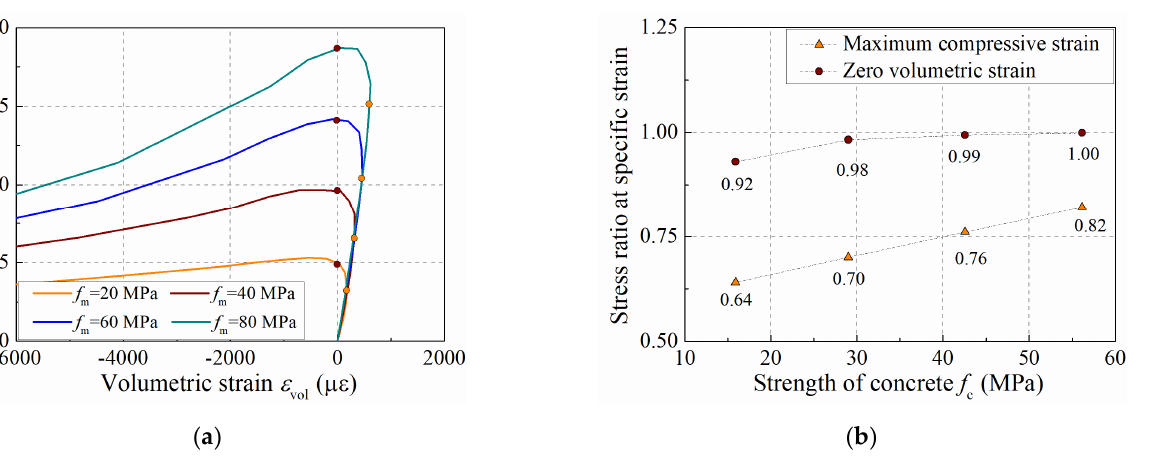
Figure 11. Volumetric dilation behavior of the concrete specimen: ( a ) σ v –ε vol curve; ( b ) stress ratio at maximum compressive strain and zero volumetric strain.